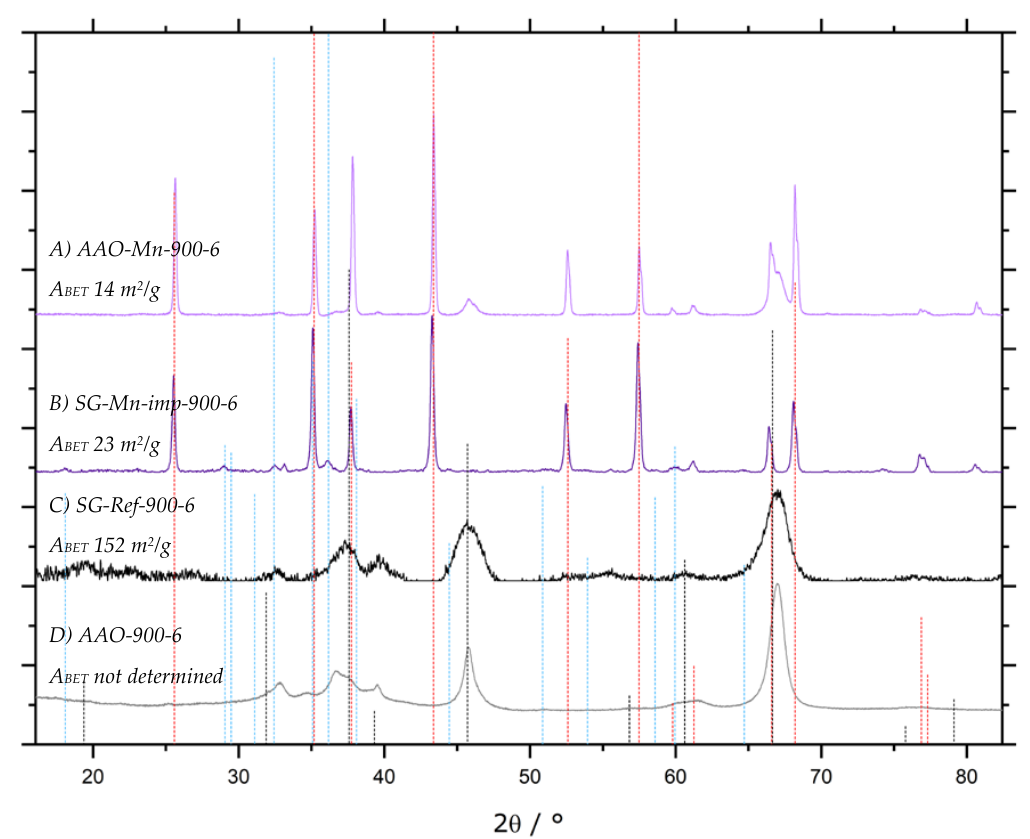
Figure 14. XRD patterns of AAO ( A, D ) and sol-gel samples ( B, C ) calcined at 900 °C for 6 h. Impregnation with manganiferous precursor solution yields almost pure α -Al 2 O 3 for AAO samples (A), with some γ -Al 2 O 3 . Mn-impregnated sol- gel material (B) shows only α -Al 2 O 3 reflexes, along with some hausmannite. Patterns (C) and (D) arise from the reference samples without impregnation. Red dotted lines indicate α -Al 2 O 3 , black dotted lines indicate γ -Al 2 O 3, hausmannite reflexes are marked in blue.